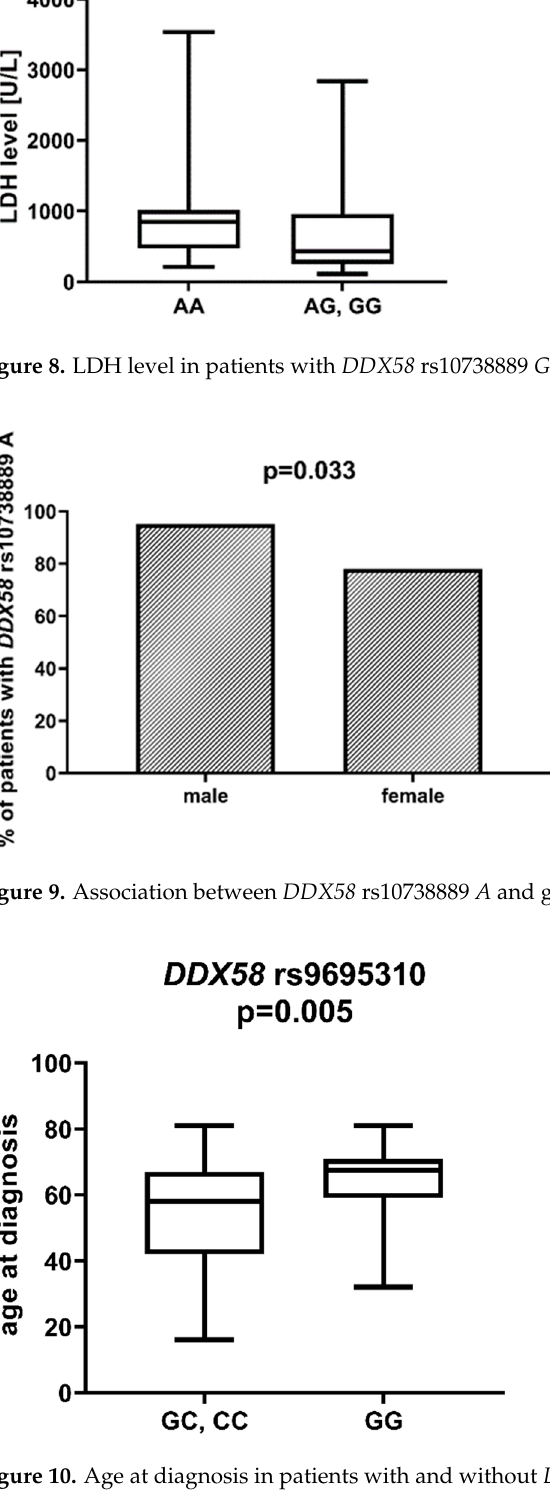
Figure 10. Age at diagnosis in patients with and without DDX58 rs9695310 C allele.